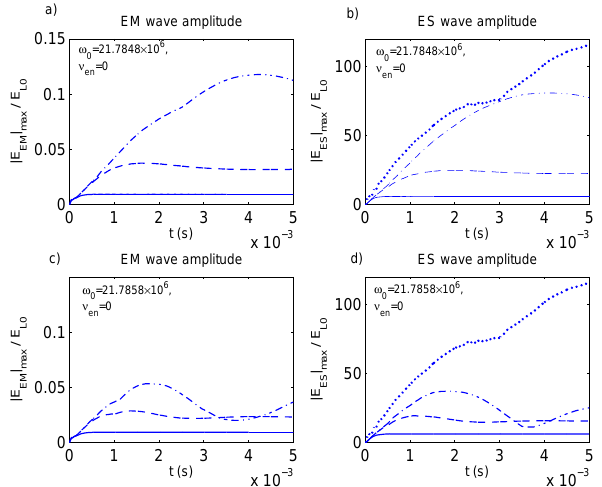
Figure 8. The amplitude of the electromagnetic waves at t = 5ms for different configurations of striations (see Fig. 3) for shallow stri- ations with relative depth α = 0 . 01, showing significant Z -mode leakage for 1 striation (panel a ), but less Z -mode radiation for 7 striations (panel b ) and 19 striations (panel c ). The separation be- tween nearest neighbor striations is 24.53m, while the wavelength of the Z mode is λ ≈ 13 .